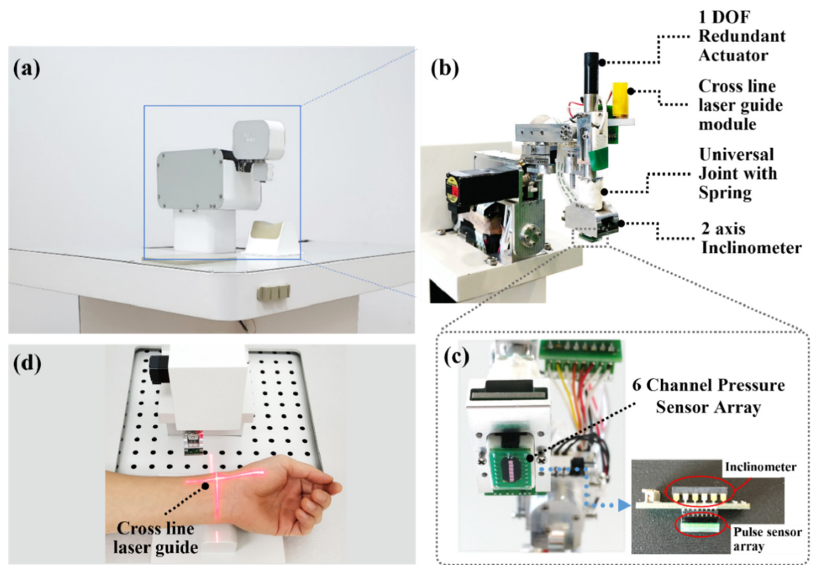
Figure 2. Robotic tonometry pulse measurement system to measure the precise pulse wave on the radial artery; ( a ) a picture of the robotic tonometry system, ( b ) components of a robotic pressure manipulator, ( c ) built-in piezo-resistive pressure sensor array, ( d ) demonstration of actual pulse measurement using a cross line laser guide.